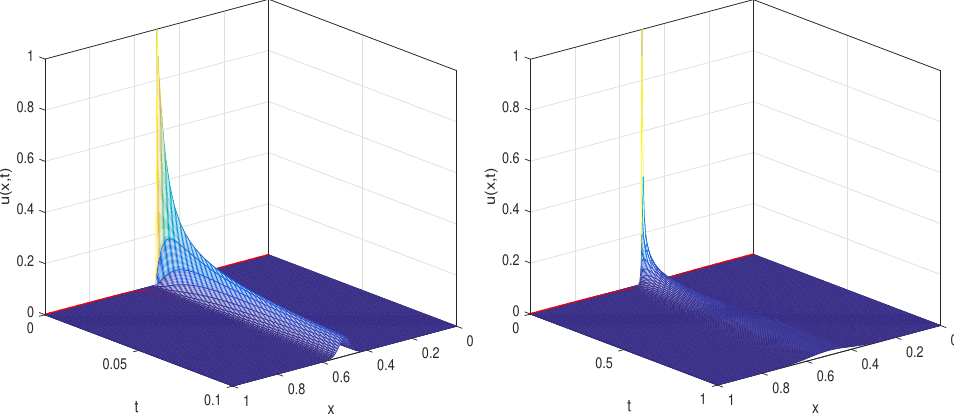
Figure 4. Time evolution graph of Example 1 at t = 0.1 LEFT and t = 1 RIGHT, using δ 1 = 1.255 and δ 2 = 1.755 with h = k = 1/200, l = 2, K = 1, and A 1 = A 2 = 1. Table 1. Example 1: Convergence results for the time-stepping